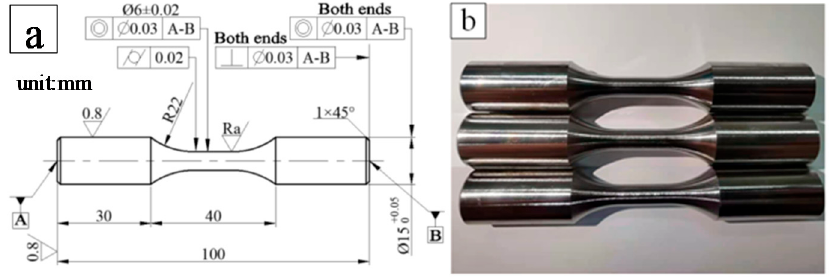
Figure 1. Material microstructure imaged by SEM (10 K × ).